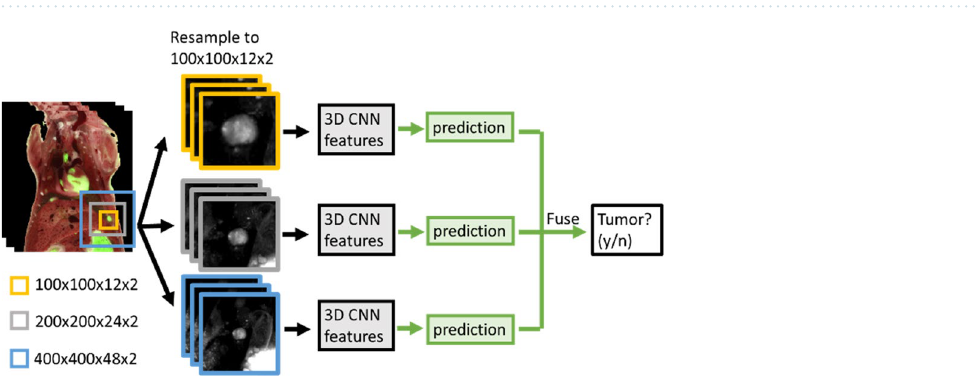
Figure 1. The CNN architecture for classification of a candidate volume as “tumor” or “not tumor”. The CNN is decomposed into two parts: 3D CNN feature extraction and prediction.